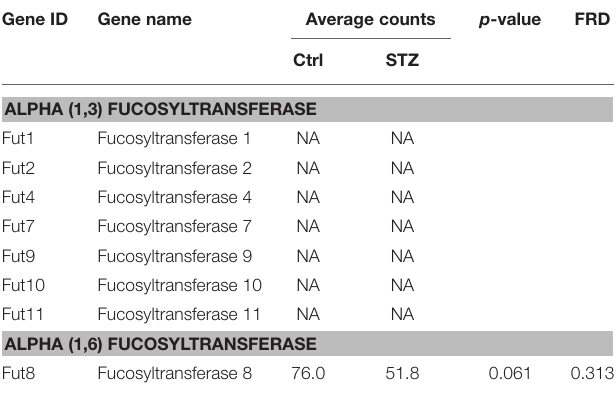
TABLE 4 | Summary of fucosyltransferase genes from kidney IM by RNA-seq analysis.